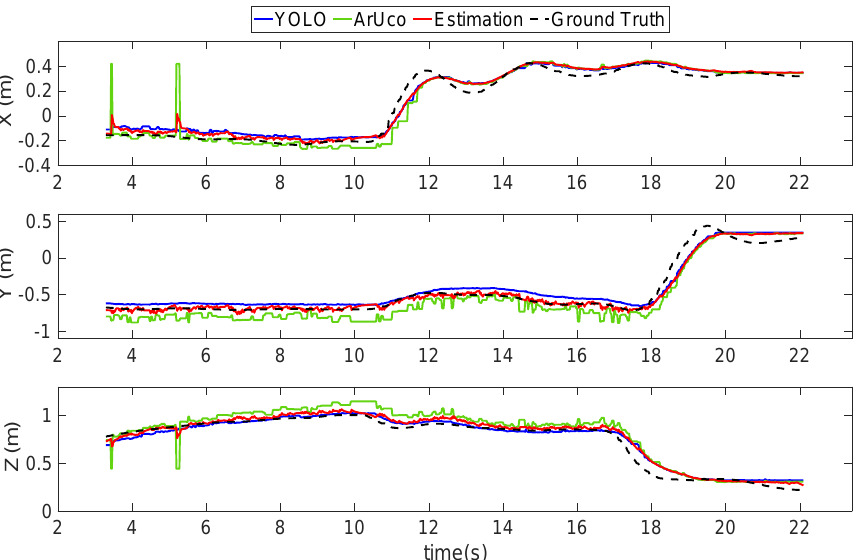
Figure 9. Flight test 1—Position estimation results using the proposed vision-based system and sensor fusion method in a moving platform landing mission.